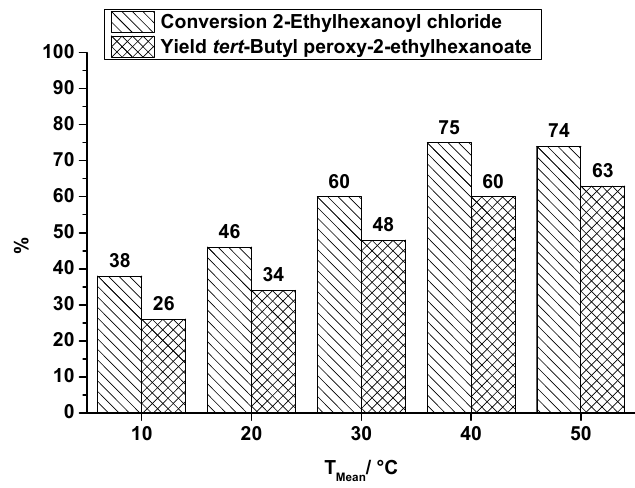
Figure 6. SAR reactor, conversion and yield of TBPEH synthesis, 2nd reaction step at a total flow rate of 0.3 mL·min − 1 depending on the reaction temperature.